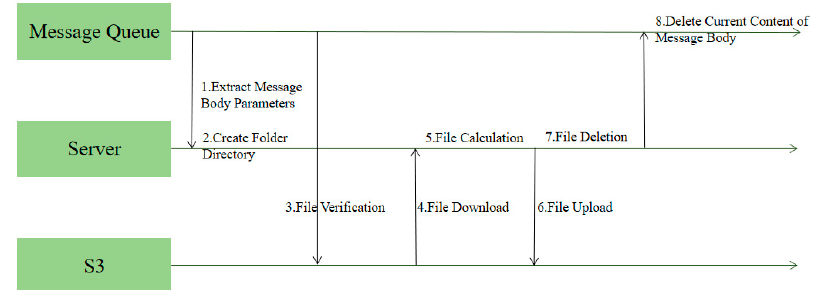
Figure 12. Polling